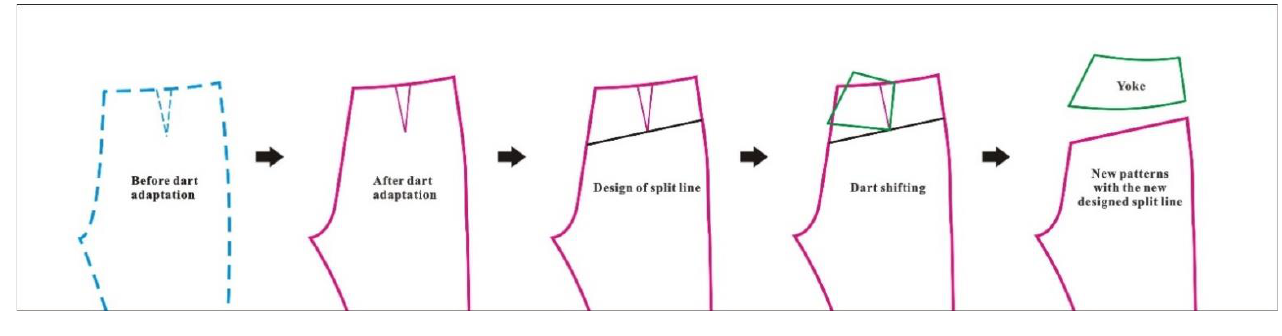
Figure 10. Associated design of the split lines.